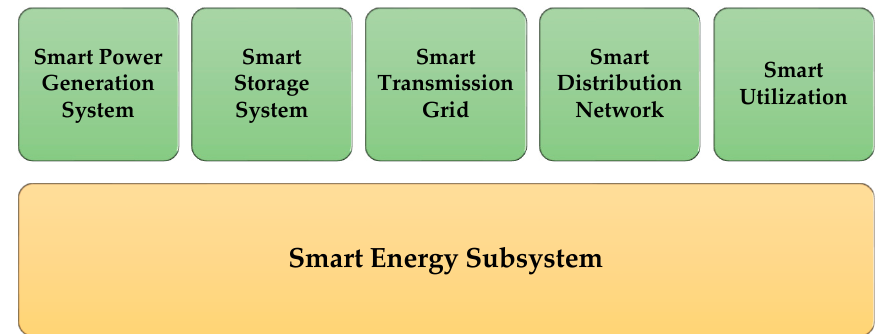
Figure 4. Smart energy subsystem.